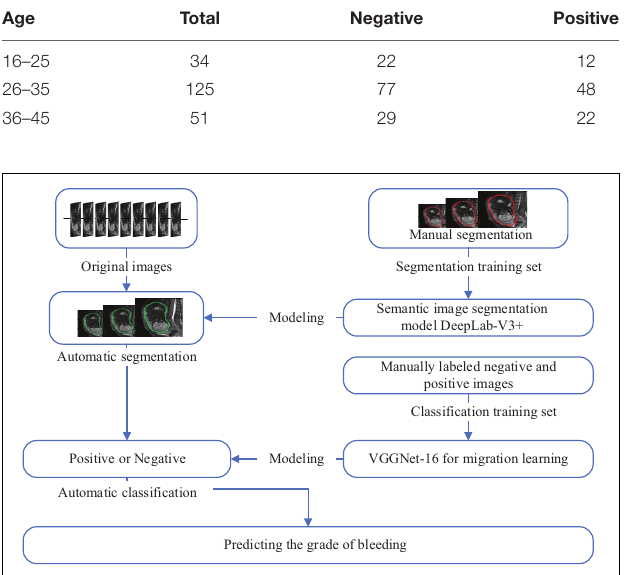
TABLE 1 | Age distribution of patients ( p = 0.97, Chi-Square test).